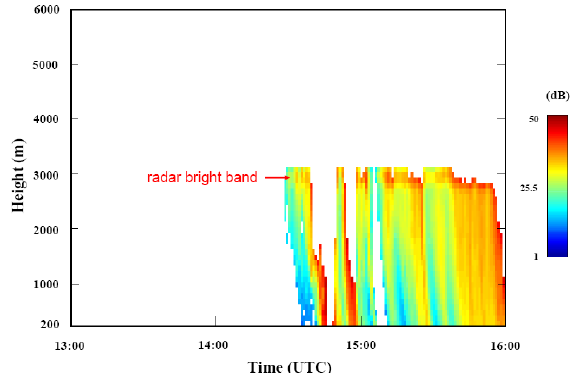
777 Figure 4. Time evolution of radar reflectivity at 24.15 GHz from 13:00 UTC to 16:00 UTC 778 Fig. 4. Time evolution of radar reflectivity at 24.15GHz from on 23 July 2007 as measured by the micro rain radar. The red arrow indicates the location of 779 13:00UTC to 16:00UTC on 23 July 2007 as measured by the micro the radar bright band. 780 rain radar. The red arrow indicates the location of the radar bright band.